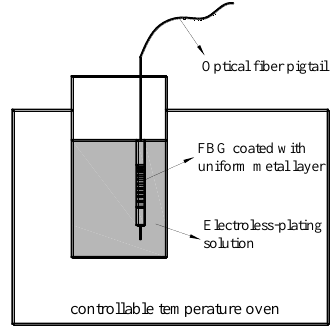
Figure 1. Diagram of electroless-plating.